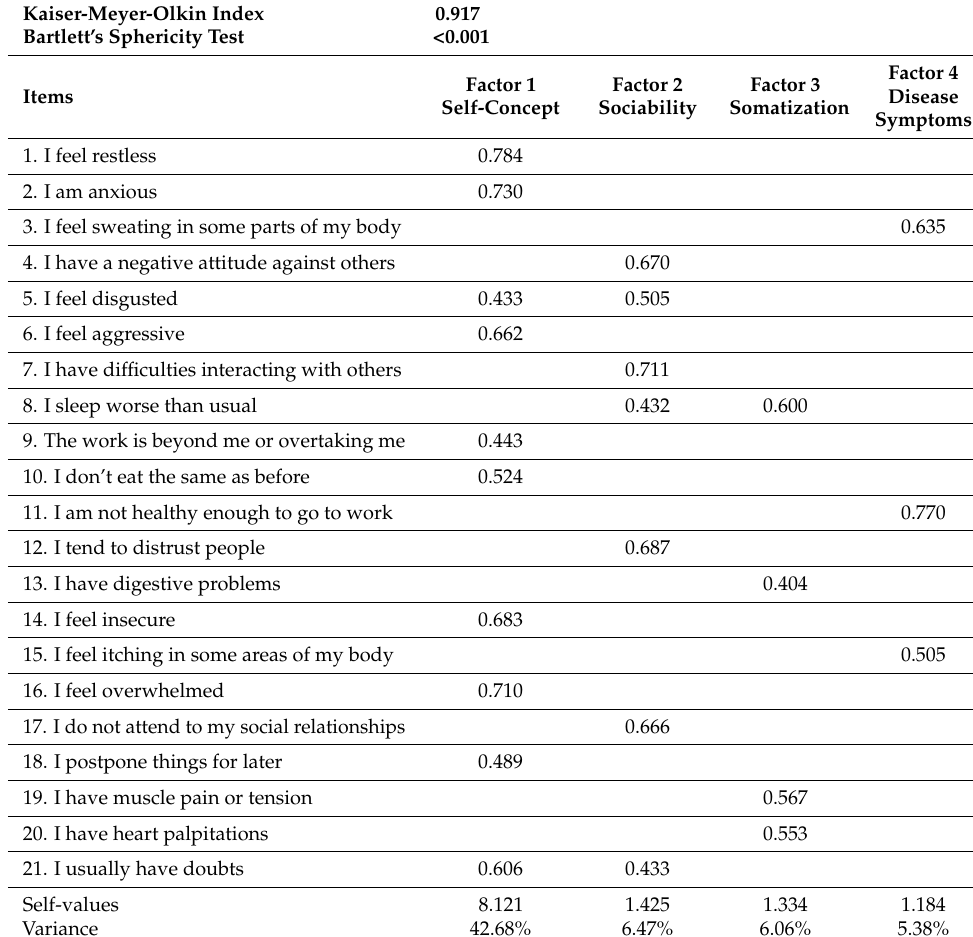
Table 2. Factorial analysis of the questionnaire: matrix of rotated